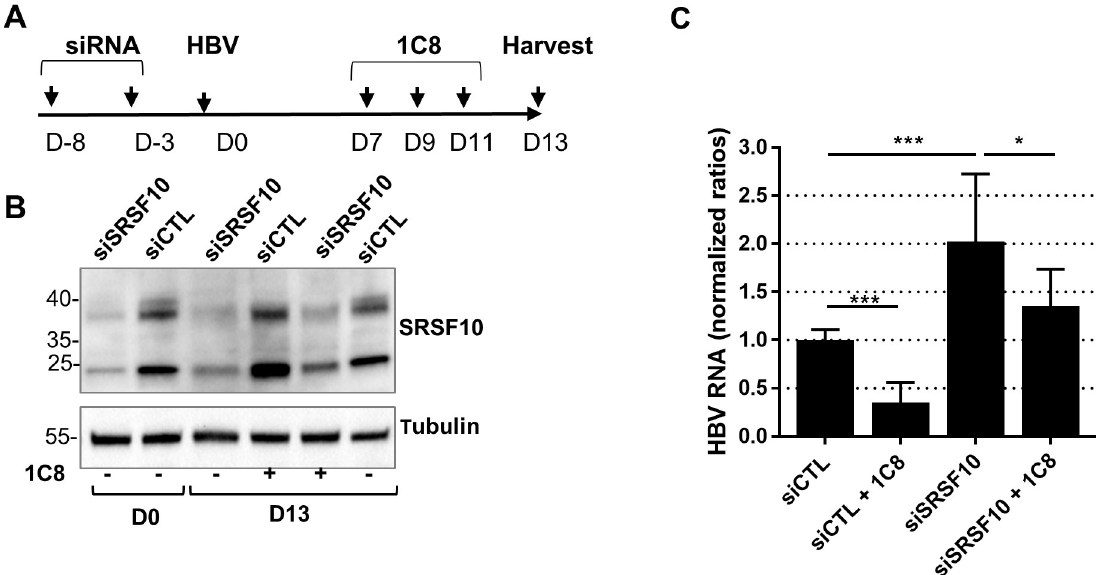
Fig 6. Combined effect of sRSF10 KD and 1C8 treatment on HBV-infected dHepaRG cells. (A) Outline of the experimental procedure: dHepaRG cells were transfected once or twice with siRNA targeting SRSF10, then infected with HBV (MOI of 250 vge/cell), and 7 days later treated three times with 1C8 (10 μ M). (B) Western blot validation showing SRSF10 depletion. (C) Quantification of intracellular HBV RNAs. Results are expressed as the mean normalized ratio +/- SD between treated and/or siSRSF10 transfected cells and siCTL- transfected cells of 3 independent experiments, each performed in